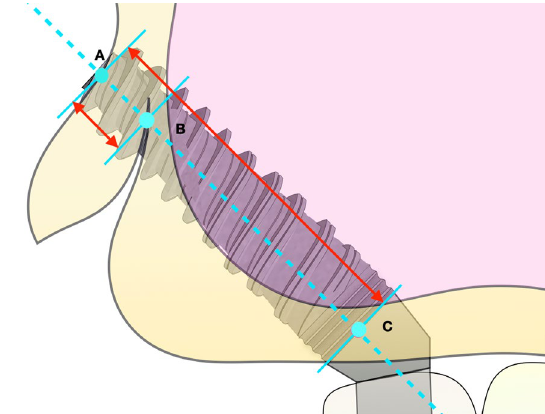
Fig. 8 When the implant (point A–point C) beyond the pterygoid maxillary junction (point B) was considered that implant apex